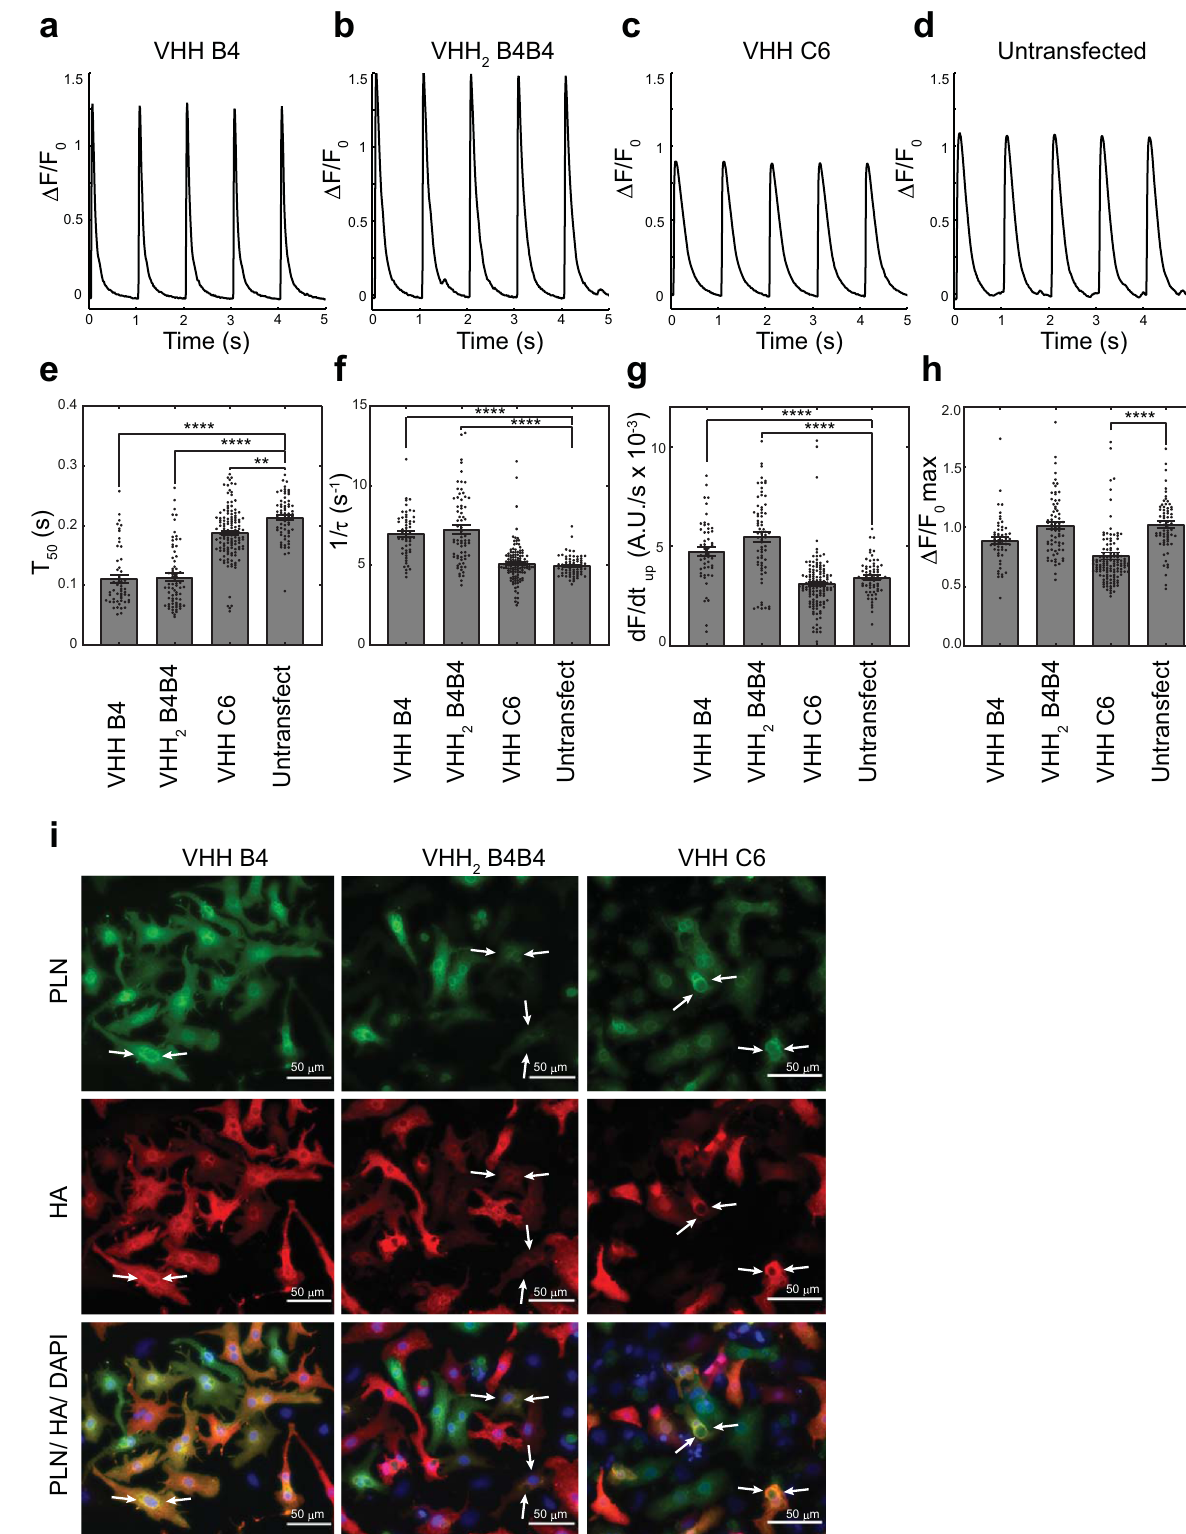
consistent with a typical transient expression observed for modRNA transfection 37 . Positively stained cardiomyocytes also showed a striated staining pattern coincident with the staining pattern produced by anti-SERCA2a antibody staining (Fig. 4d), indicating that both intrabodies and SERCA2a are co-localised at the sarcoplasmic